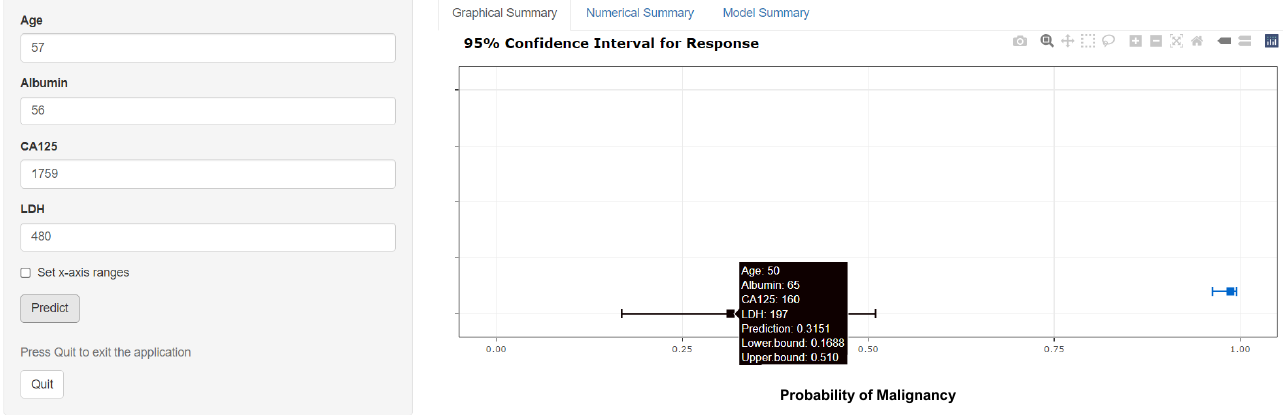
Figure 7. Interactive nomogram for predicting the malignancy of a suspect adnexal mass (https://pils.shinyapps.io/AROMA/) accessed on 21 June 2022. Two predictions are shown; the black one with a prediction of 31.5% malignancy and parameter values shown in the black box, and the blue one with a prediction of 98.7% malignancy and parameters shown in the left input box. The characteristics of the model can be seen following the “Model Summary” link. Used units are indicated in square brackets.